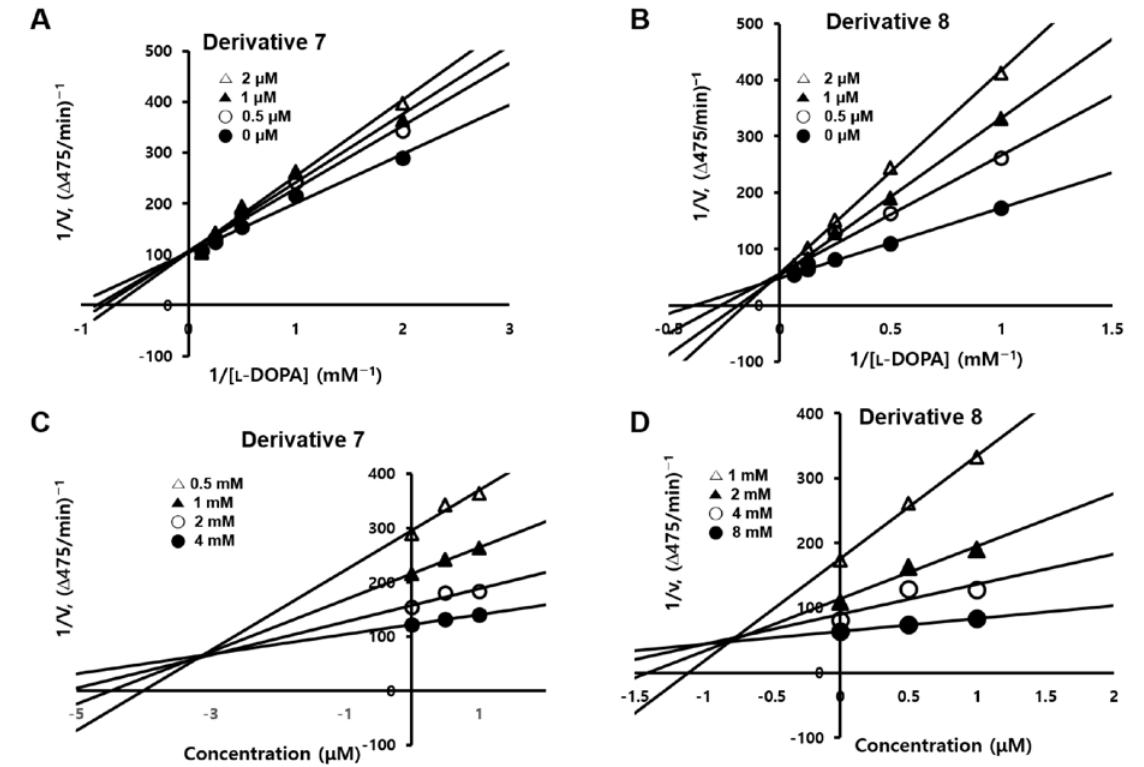
Figure 3. Lineweaver–Burk plots ( A , B ) and Dixon plots ( C , D ) for derivatives ( Z )-2-(benzylamino)-5-(3-hydroxy-4-methoxybenzylidene)thiazol-4(5 H )-one ( 7 ) and ( Z )-2-(benzylamino)-5-(2,4-dihydroxybenzylidene)thiazol-4(5 H )-one ( 8 ). Kinetic studies for Lineweaver–Burk plots were carried out using four different concentrations (0, 0.5, 1, and 2 µM) of 7 and 8 in the presence of five different concentrations of L -dopa. Dixon plots for 7 and 8 were obtained by transforming the corresponding Lineweaver–Burk plots.